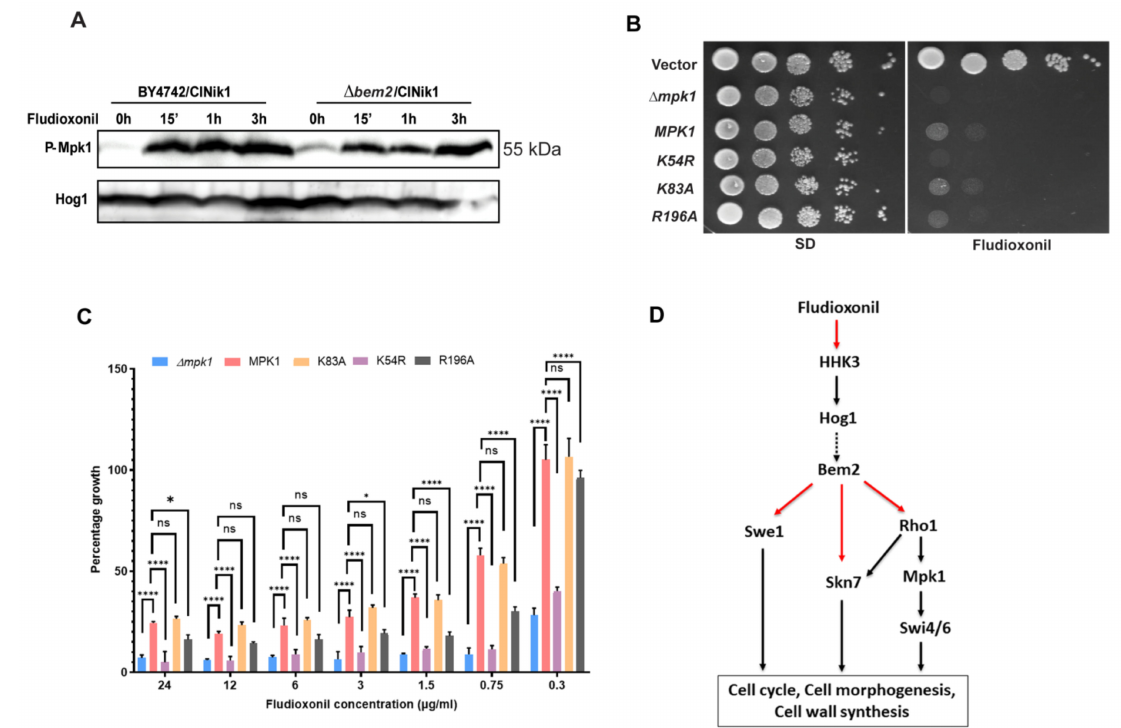
Figure 4. Role of CWI pathway in the cytotoxic effect of fludioxonil in S. cerevisiae. ( A ) Western blotting showing the activation of CWI pathway upon fludioxonil treatment. Cells were grown in SD media (-His) at 28 ◦ C until an OD 600 of ~0.8 and treated with fludioxonil (25 µ g/mL) for different time intervals. Total cell extract from these samples was used for western blotting analysis. Blots were ana- lyzed using an anti-phospho-p44/42 MAPK antibody that recognizes the dual-phosphorylated form of ScMpk1 and anti-Hog1 antibody for total Hog1 (Hog1) for loading control. The data shown are rep- resentative of three independent experiments. ( B ) Fludioxonil sensitivity of ∆ mpk1 strain harboring two plasmids pRS313 and p426ClNik1 ( ∆ mpk1 ), pMPK1-313 and p426ClNik1 (MPK1), pMPK1-54 and p426ClNik1 (K54R), pMPK1-83 and p426ClNik1 (K83A), and pMPK1-196 and p426Nik1 (R196A) by dilution spotting on SD plate with 25 µ g/mL fludioxonil. ∆ mpk1 strain harboring plasmids pRS313 and pRS426 (vector) was used as control. The data shown are representative of three independent experiments. ( C ) Relative growth of ∆ mpk1 strain harboring plasmids pRS313 ( ∆ mpk1 ), pMPK1-313 (MPK1), pMPK1-83 (K83A), pMPK1-54 (K54R), pMPK1-196 (R196A) along with p426ClNIK1 on